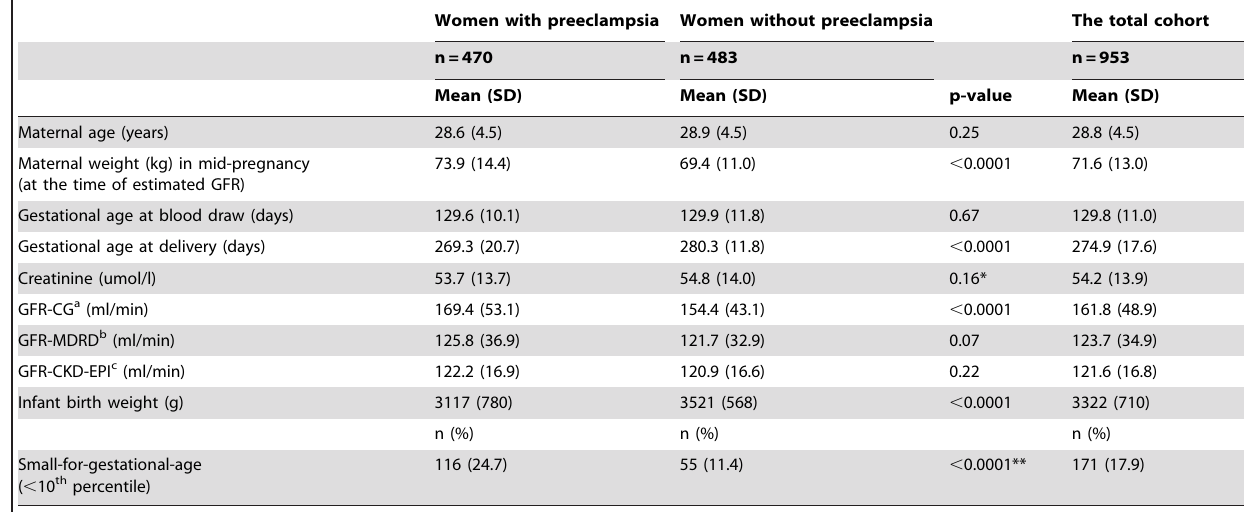
Table 1. Characteristics of 953 pregnant women in the Norwegian Mother and Child Cohort study, Norway, 2003–2007.